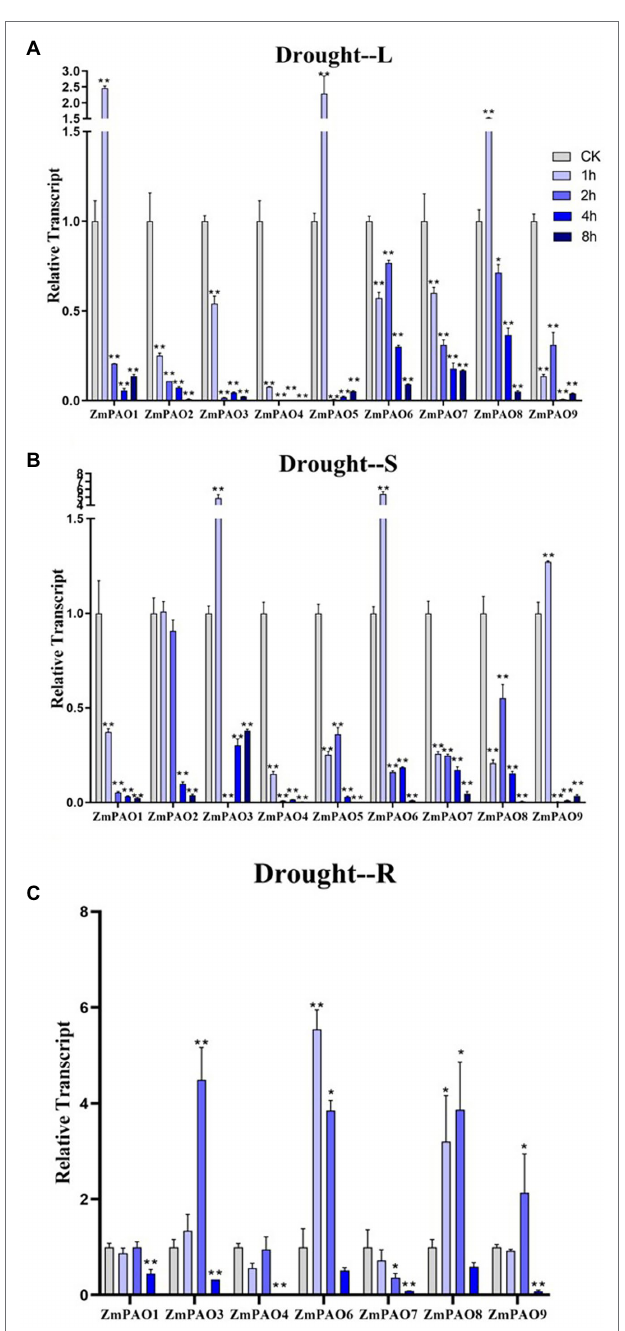
FIGURE 9 | Expression profiles of ZmPAO genes under drought stress treatment in different tissues. qRT-PCR data was normalized using ZmActin gene. (A–C) Expression profiles of ZmPAO genes under drought stress in leaves, stems, and roots, respectively. Error bars are caused by three biological replicates. Asterisks above the error bars represent statistical significance using one-way ANOVA and a Fisher’s LSD. * Significantly different at p < 0.05; ** significantly different at p <